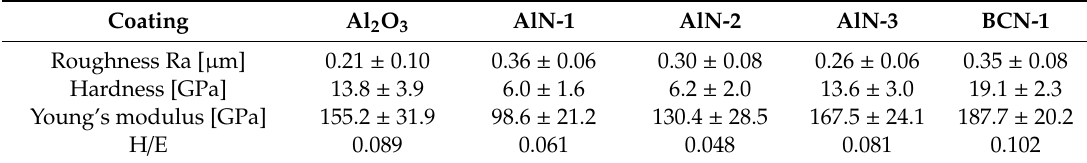
Table 2. Roughness and mechanical properties of the nitride thin films, as well as the Al 2 O 3 coating. Coating Al 2 O